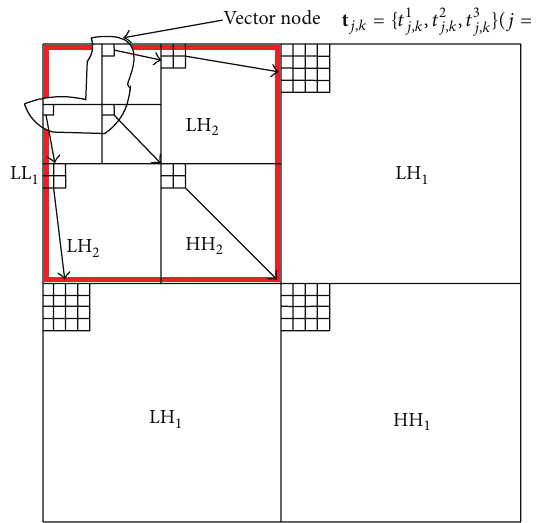
Figure 1: Illustration of 𝐽 = 3 wavelet pyramid decomposition, the VWD-HMM, and a vector quad-tree of wavelet coefficients (3 levels). The square block with thick solid lines denotes the LL 1 subband at the finest pyramid level, which is further decomposed to form the subbands of LH 2 , HL 2 , HH 2 , and LL 2 at the second level. And so do the four subbands at the third